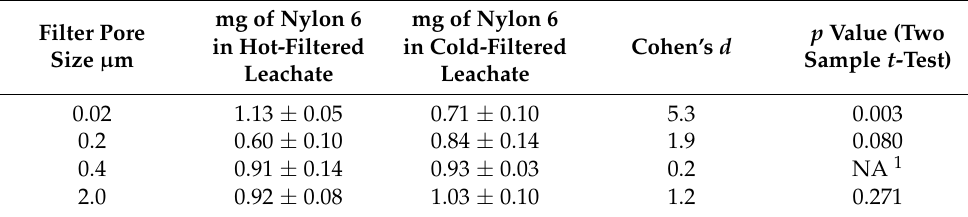
Table 1. Quantities of nylon 6 (mg) from teabag leachates after filtration with different pore sizes. The mass (mg) of nylon 6 quantified with the FT-IR method using KBr pellets on teabag leachates after filtration with different pore size filters immediately after teabag removal (“hot-filtered” leachate) or after cooling at room temperature (“cold-filtered” leachate). The values refer to the amount of nylon 6 found in the liquid portion recovered in the receiving flask (n = 3, data are presented as means ± standard deviations). In the last columns, the Cohen’s d and the p values for the two-sample t -test are